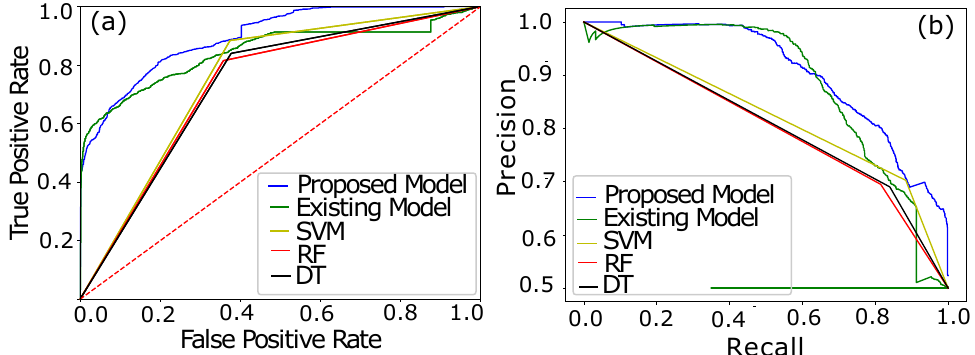
Figure 6. ( a ) AUC Analysis of the proposed and CNN–LSTM models. ( b ) PRC analysis of both models.